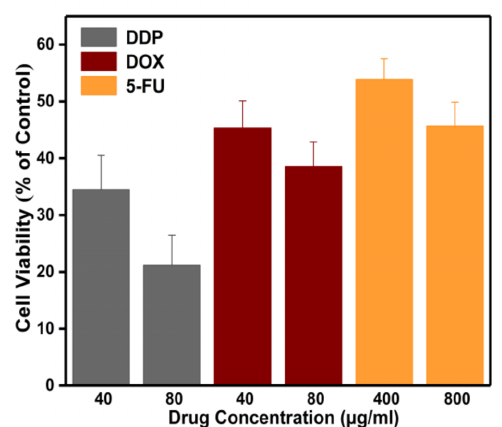
Figure 7. Viability of HeLa cells by dose-dependent DDP, DOX, and 5-FU for 24 h. Cell viability is represented by the ratio of the absorbance (OD) values of cells treated with drugs to the OD values of the control